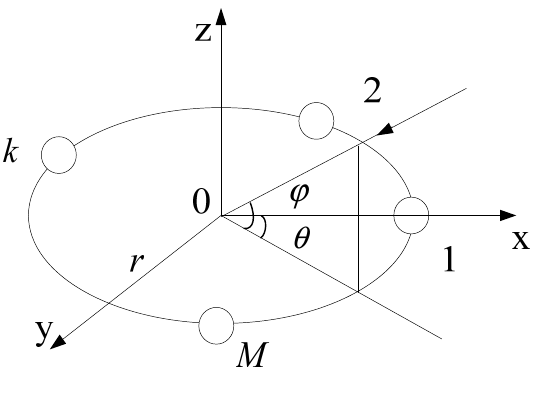
Figure 1. Uniform circular array